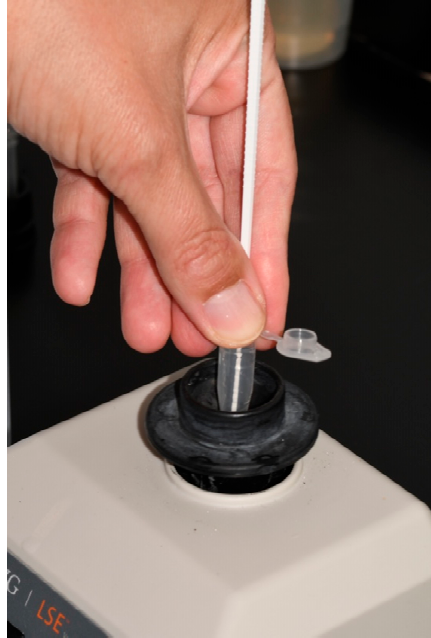
Figure 6. Vortexing of tube containing the infusion and plastic inoculating loop. Serial dilutions were performed in 96 microtiter microplates; 20 μ L of suspension was added to 180 μ L of nutrient broth and mixed, and 20 μ L was transferred to the next well. Serial dilution up to 8 dilutions were performed. From each well, we transferred 50 μ L to a blood agar plate. After an incubation period of 48 h at 37 °C, the CFUs were counted (Figure 7).